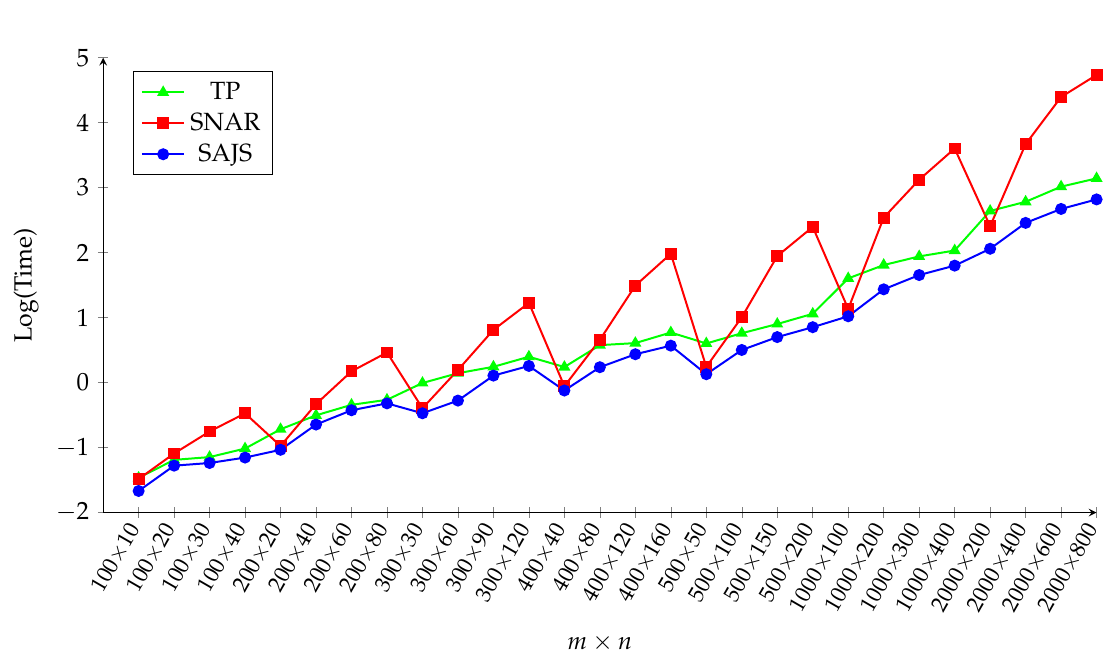
Figure 6. The comparison of SAJS, the Two-Phase method (TP), and SNAR using the average wall-clock time—randomly generated linear programming